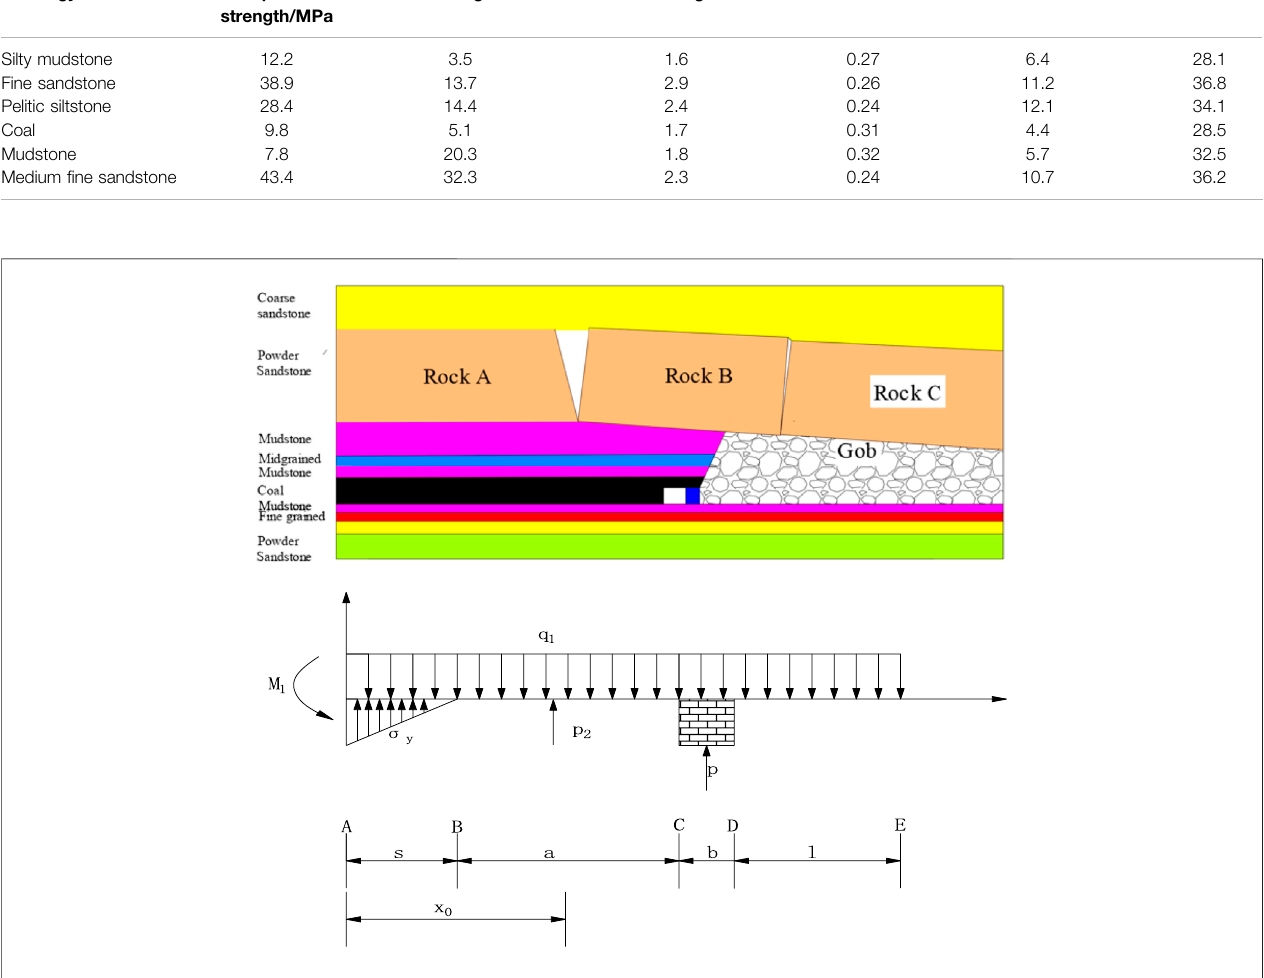
Frontiers in Earth Science |